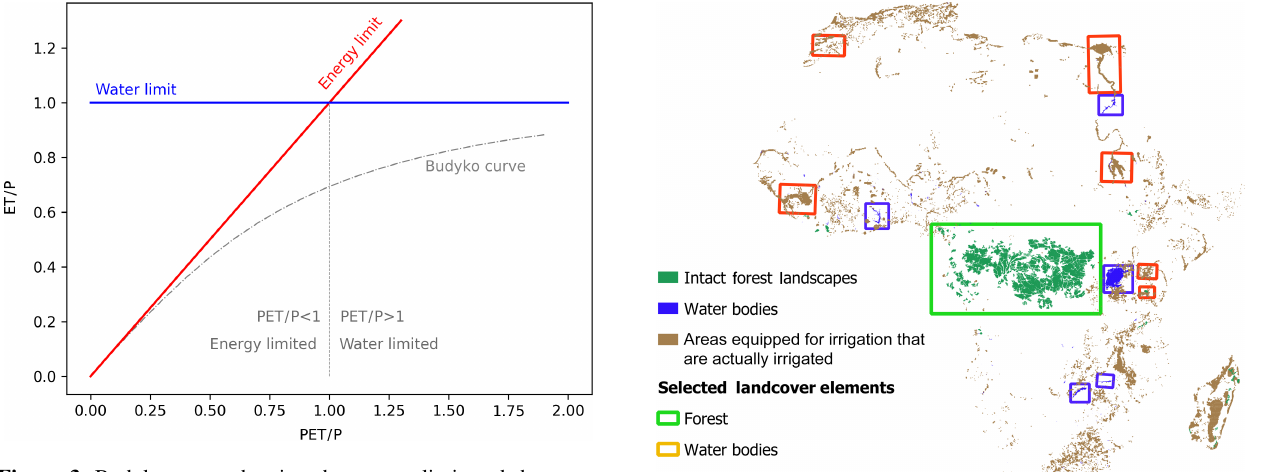
Figure 3. Budyko curve showing the energy limit and the water limit.